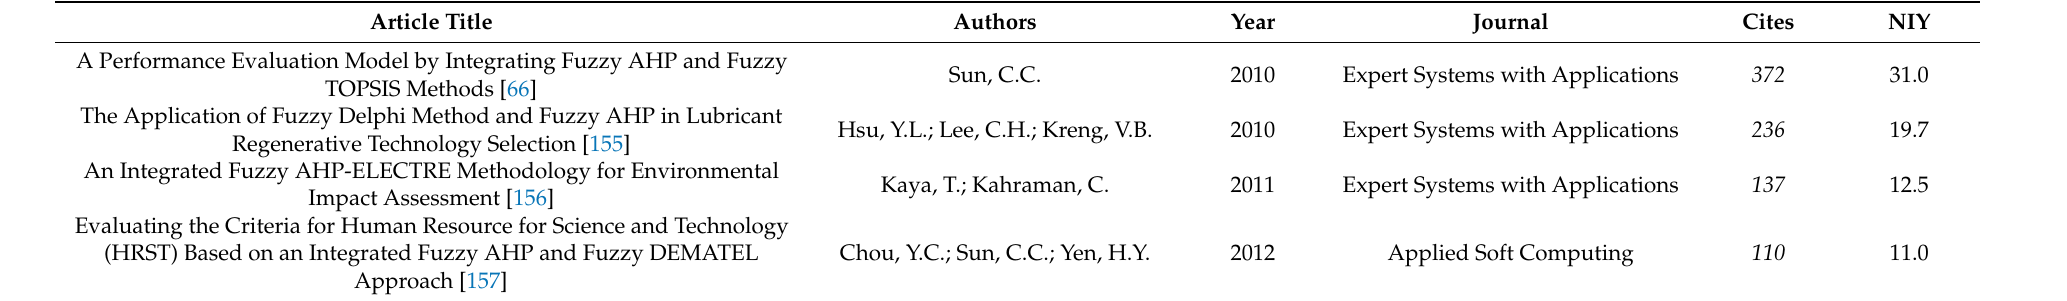
Table A6. Articles included in Cluster 6 sorted by